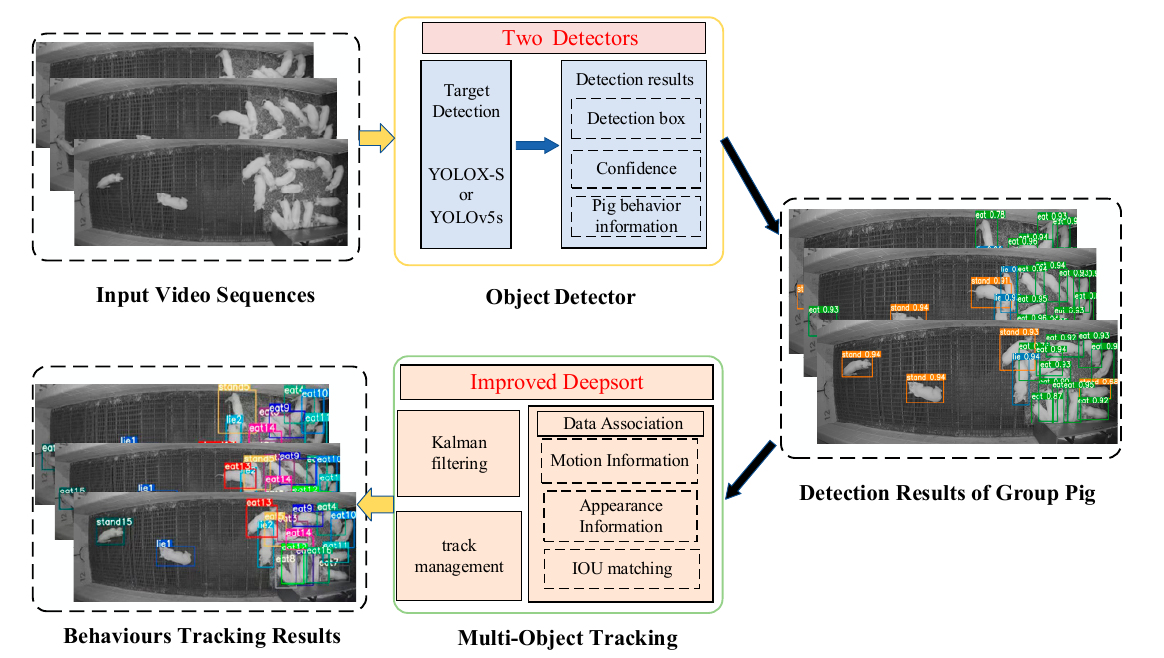
Figure 3. Architecture proposed for automated behavior recognition and tracking of group-house pigs.